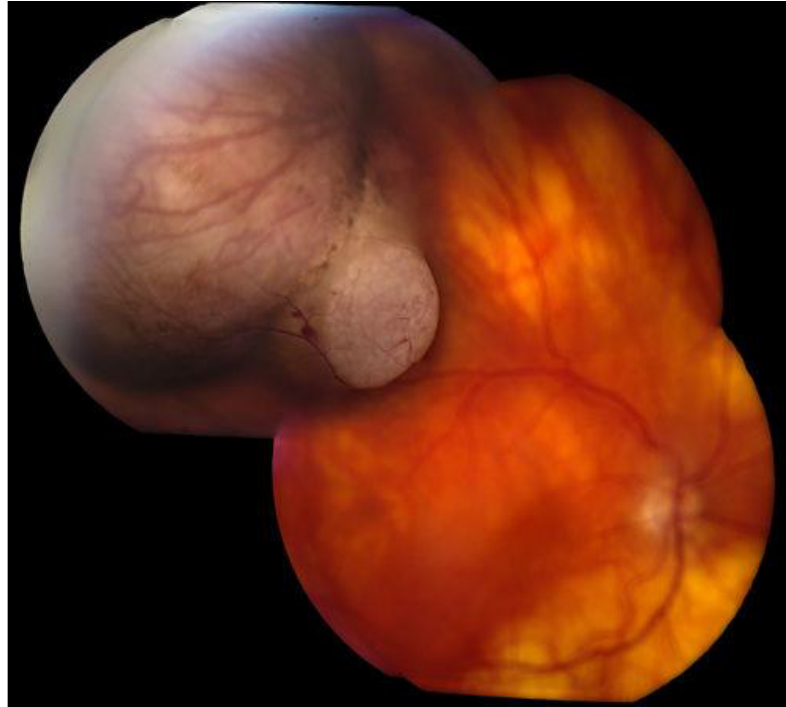
Figure 3. Amelanotic choroidal melanoma.